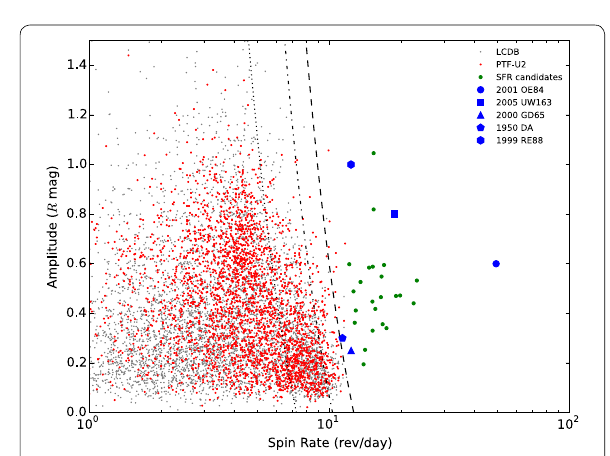
Fig. 4 Light‑curve amplitude vs. spin rate. The symbols are the same as in Fig. 3. The dashed , dot-dashed, and dotted lines represent the � m )/ρ (Pravec and Harris 2000), for 3.3 √ ( 1 spin‑rate limits, P ∼ + rubble‑pile asteroids with a bulk densities of ρ 3, 2, and 1 g cm − 3 , = respectively. Note that the asteroids of D < 0.2 km are not included in this plot. This figure is reproduced from Chang et al. (2015,